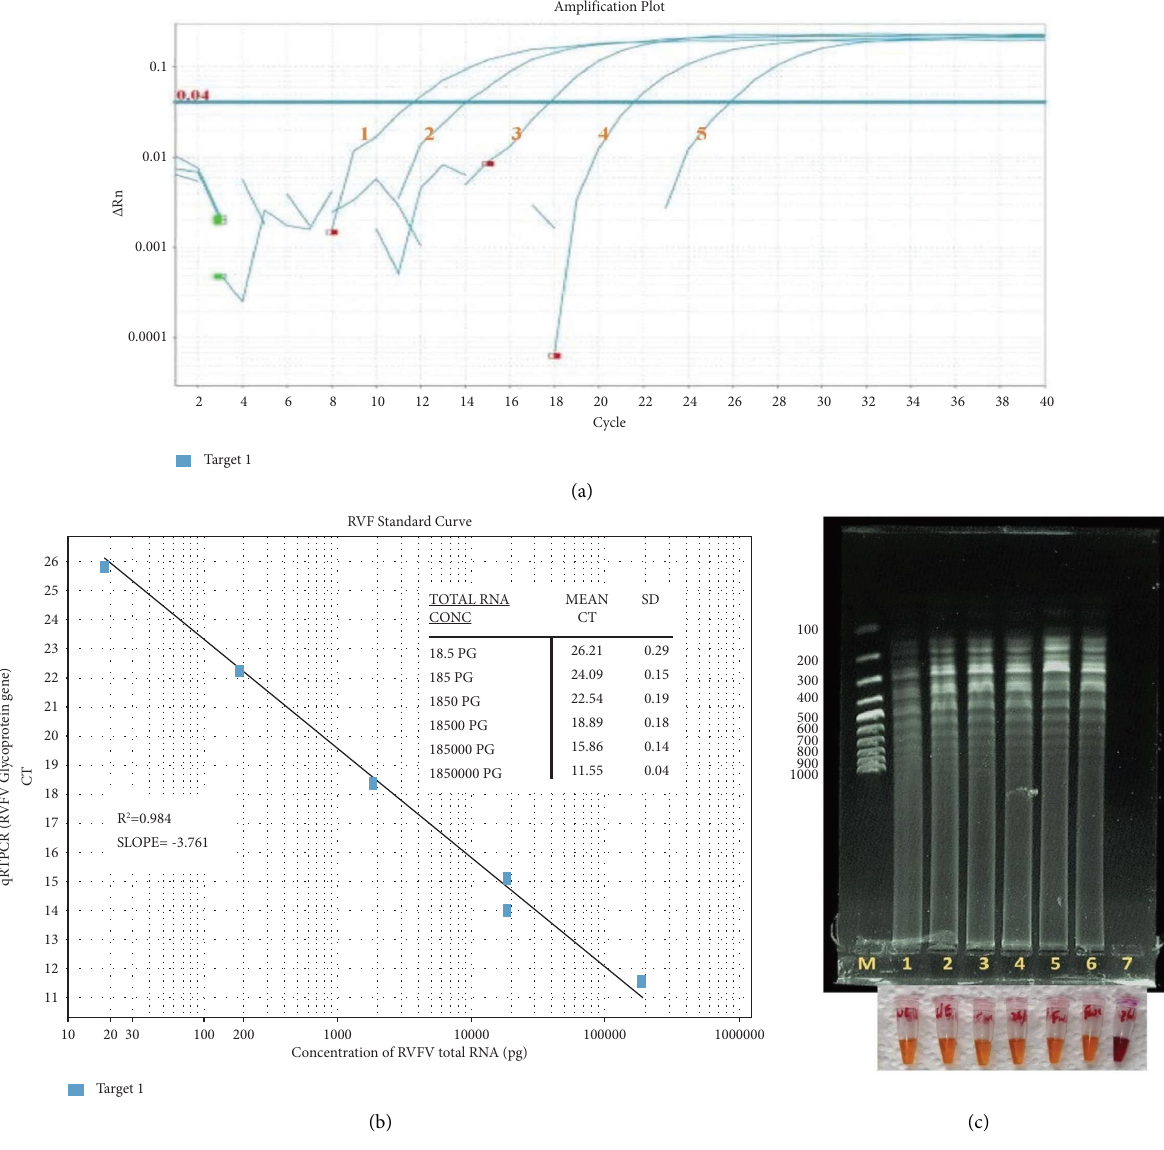
Figure 9: Detection limit of the new colorimetric-RVFV-UDG-RT-LAMP assay. (a) Analytical sensitivity of qRT-PCR of six replicates determined by tenfold dilution of known concentration of RVFV total RNA (18.5pg–1850000 pg). (b) Standard curve generated by plotting the number of RVFV RNA copies ( x -axis), and the mean of the corresponding qRT–PCR threshold cycle (Ct) of three independent experiments on the y -axis. (c) Limit of detection of the RVFV-UDG-RT-LAMP assay using a tenfold dilution of known concentration of RVFV total RNA as described under qRT-PCR as monitored through color change and resolved on 1% agarose gel electrophoresis. Te M-100bp molecular ladder (Cat SM0241, Termo Fisher Scientifc Inc., USA), 7-NTC , 1 – 6 tenfold dilution from 18.5pg to 1.85 × 10 6 ,